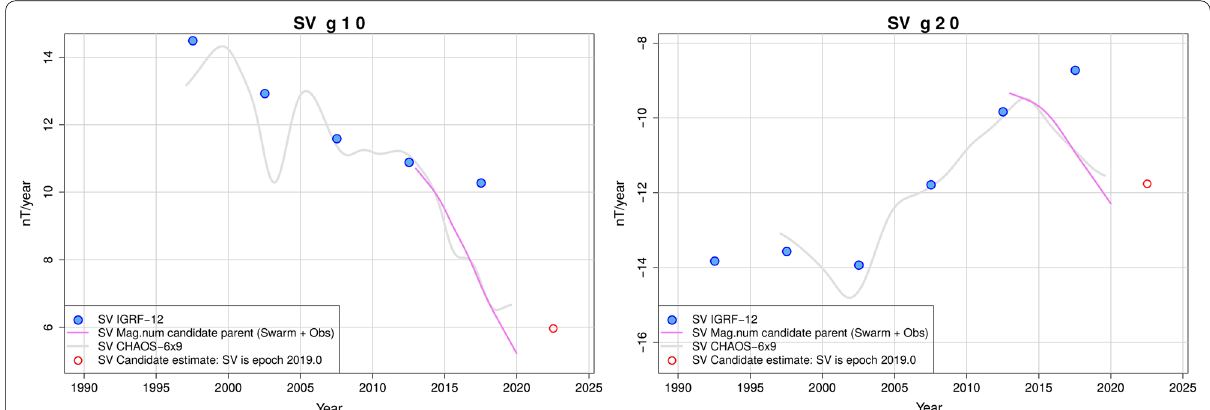
Fig. 2 Two examples from low-degree coefficients ( g 0 1 and g 0 2 ) showing the secular variation from IGRF-12 (values for 1997.5 to 2012.5 calculated as linear SV from the adjacent main field coefficients), the Mag.num parent model and the more variable CHAOS-6 model. The red circle indicates our chosen value as predicted secular variation for the coefficients for 2020 to 2025, taken to be the SV of the parent model at epoch